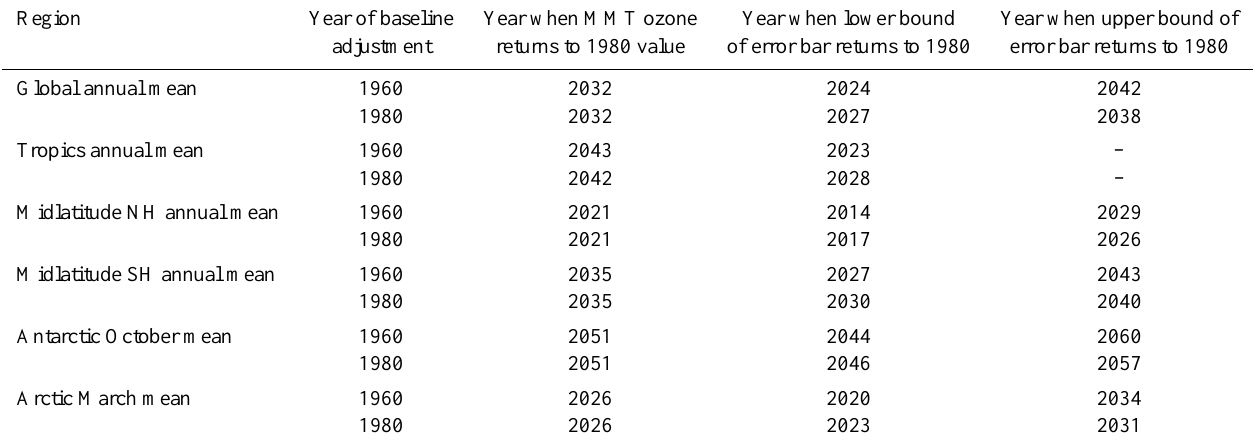
Table 3. Date of return to 1980 total column ozone in the reference simulations as derived from Fig. 10. Region Year of baseline Year when MMT ozone Year when lower bound adjustment returns to 1980 value of error bar returns to